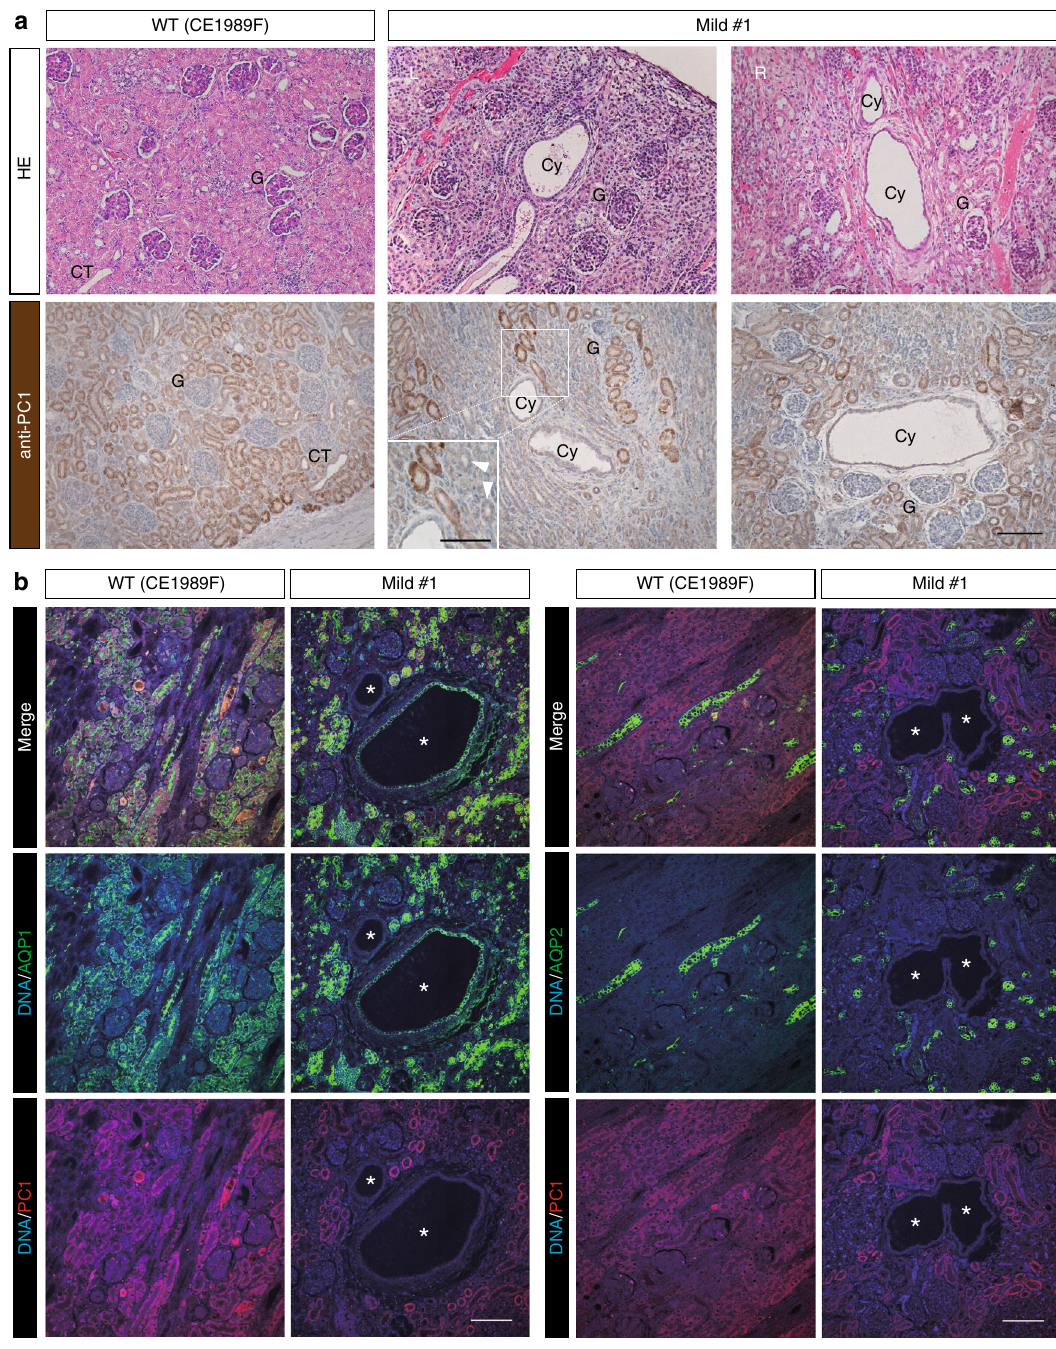
Fig. 3 Mimicking the result of several “ two-hit ” mutations. a H&E-stained images and the expressions of PC1 in mild-type kidneys. The upper row of H&E- stained images shows cyst formation in the kidneys. The lower row of immunohistochemically stained images shows the expression of PC1. “ G ” indicates glomeruli, “ Cy ” indicates cysts, and “ CT ” indicates collecting ducts. Arrowheads indicate PC1-negative tubules. Scale bar, 100 µ m. b The expressions of AQP1, AQP2, and PC1 in a mild-type kidney. Asterisks indicate cysts. Scale bar, 100 µ